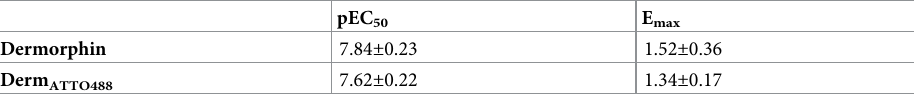
Table 2. GTP γ [ 35 S] binding in CHO hMOP cell